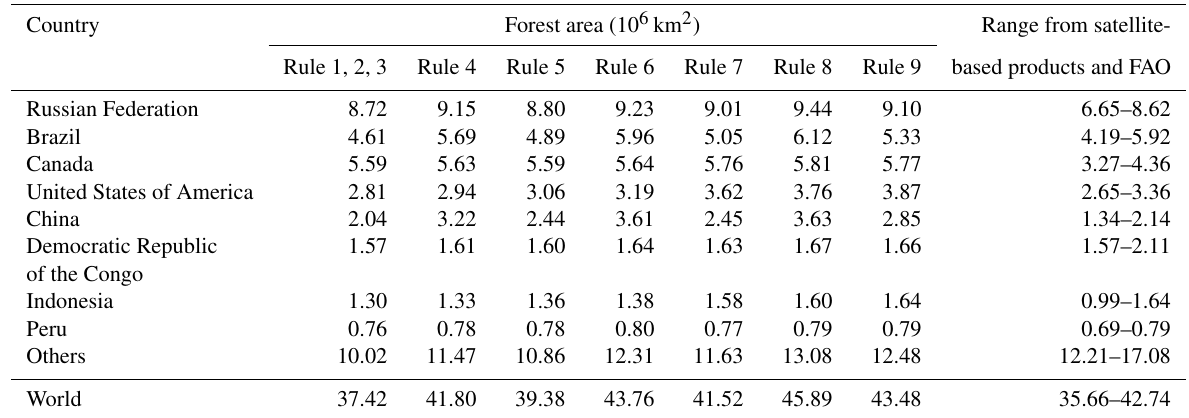
Table 4. Forest area (10 6 km 2 ) in 2000 of eight countries with the largest forest area and all other countries combined (“Others”), estimated by the nine translation rules, range compiled from satellite-based datasets and FAO report.